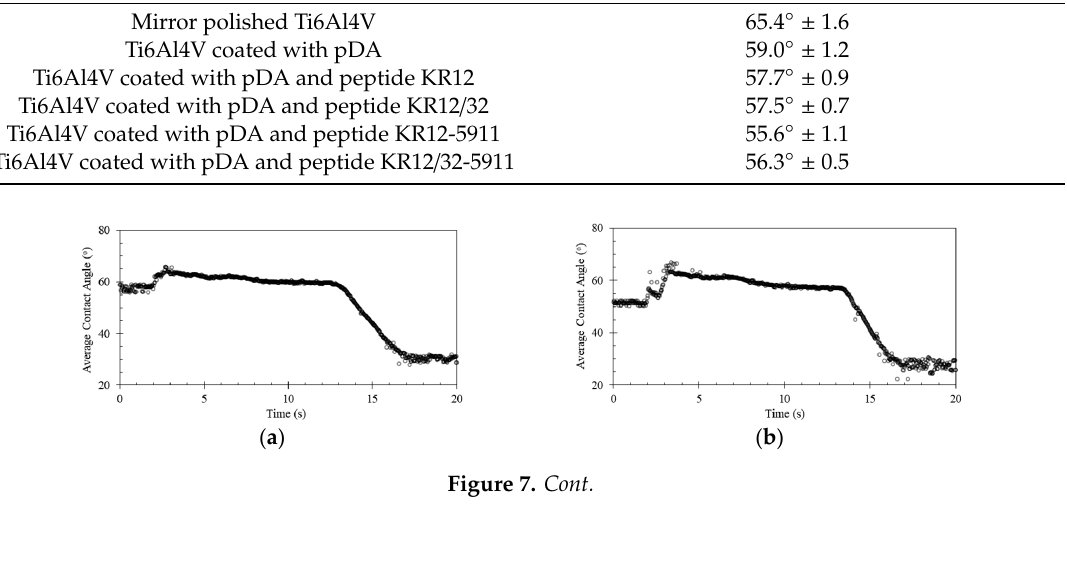
Surface Surface